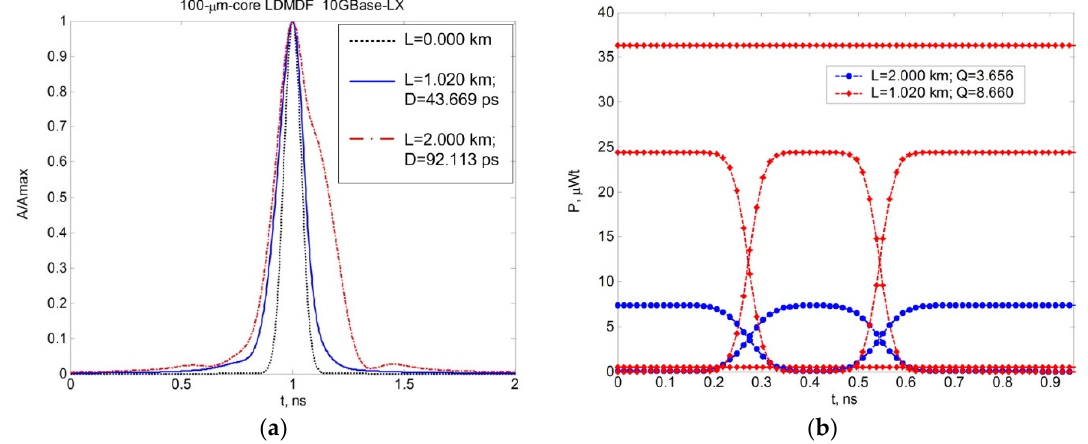
Figure 13. 10GBase-LX data transmission over a 100 μm core LDMDF without special launching conditions: ( a ) pulse response; ( b ) eye diagram envelope.